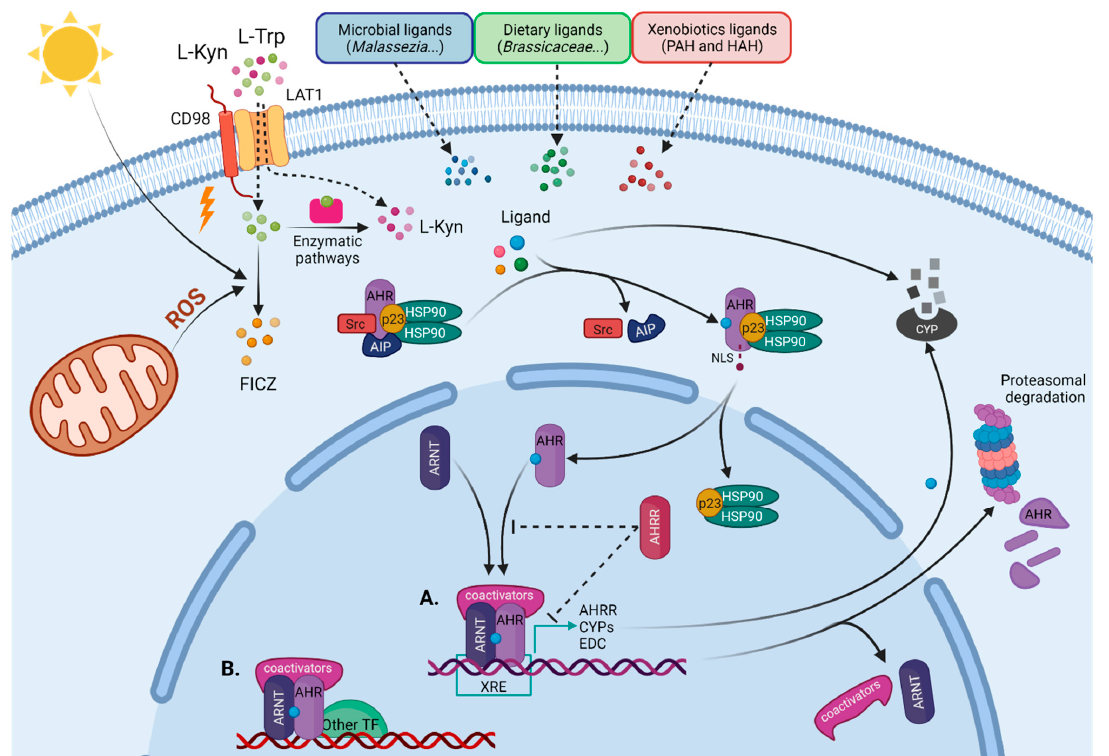
Figure 1. AHR genomic signaling pathway. Before ligand binding, AHR is bound by a chaperone complex (described in the text and the figure), which maintains its localization in the cytoplasm. Cells are exposed to different AHR ligands, such as bioproducts of microbiota, phytochemicals, xenobiotics, or endogenous ligands, mostly derived from L-tryptophan (L-Trp). When a ligand binds, the AHR changes its conformation and c-Src and AHR-interacting proteins (AIP) are released, resulting in the exposure of the nuclear localization signal (NLS) in the AHR’s N-terminus, that allows docking of importin β and mediates nucleocytoplasmic shuttling. Once in the nucleus, the ligand-activated AHR heterodimerizes with its protein partner, the AHR nuclear translocator (ARNT), at the time it dissociates of cytoplasmic chaperone complex. ( A ) The ligand–AHR–ARNT heterodimeric complex binds specific DNA sequences located in the promoter regions of target genes, named xenobiotic responsive elements (XRE), and recruits additional coactivators and components of the transcriptional machinery (described in the text) that are required to initiate transcription of the target gene. ( B ) The ligand–AHR–ARNT complex can also interact with non-canonical AHR partners and regulate additional target genes. ( A ) Canonical genes include enzymes of the cytochrome P450 (CyP) family and AHR repressor (AHRR). CyP enzymes metabolize AHR ligands and the AHRR competes with the AHR for interaction with the ARNT and DNA binding. After transcription, the AHR is exported out of the nucleus and is rapidly degraded by the proteasome. PAH—polycyclic aromatic hydrocarbon; HAH— halogenated aromatic hydrocarbon; ROS—reactive oxygen species; HSP90—90 kDa heat shock protein; EDC—epidermal differentiation complex; TF—transcriptional factor. Figure was created with